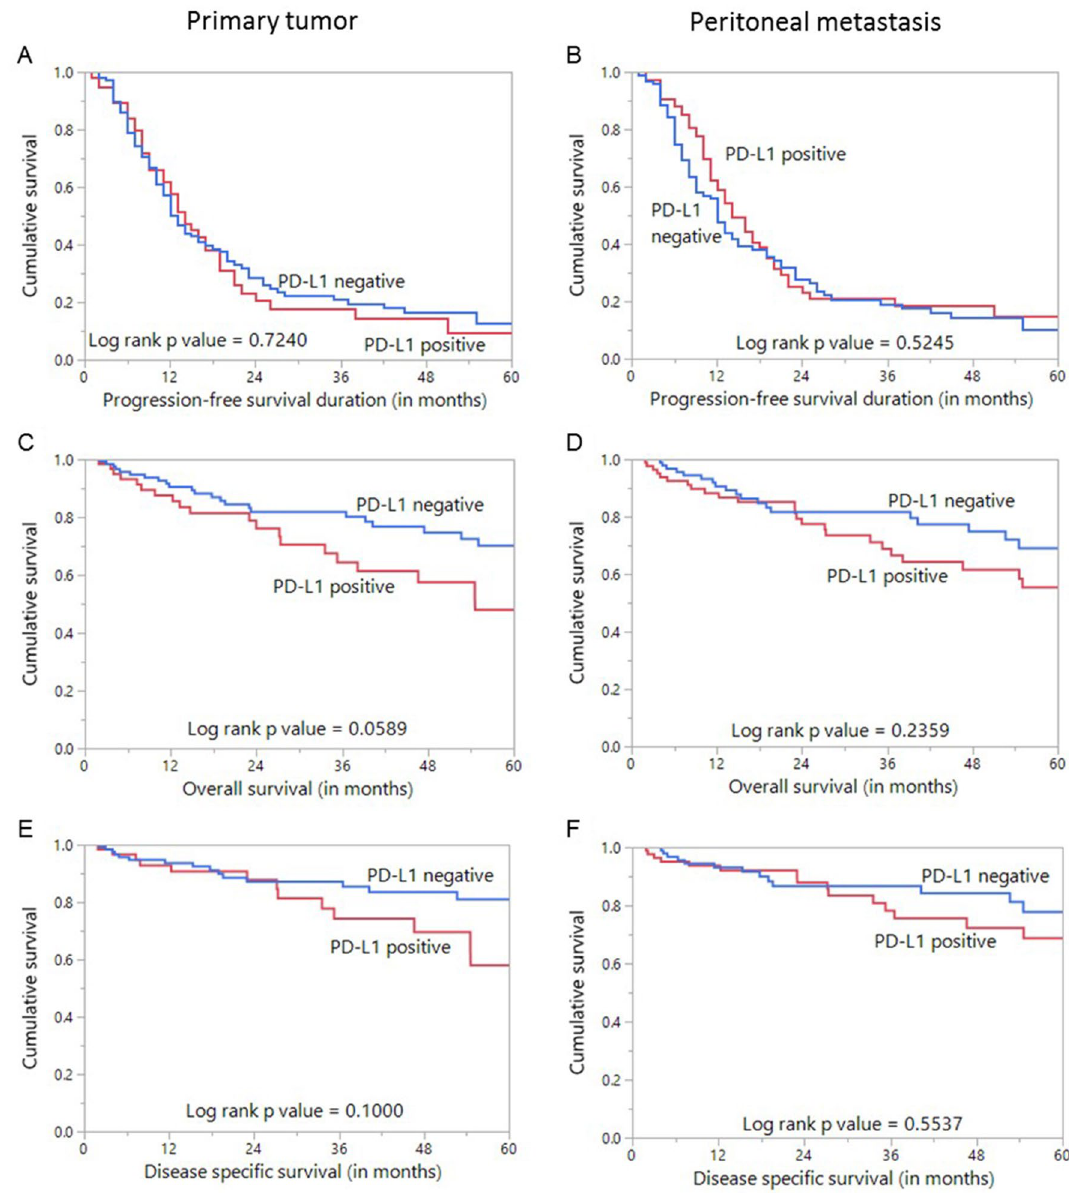
Figure 2. Survival analysis of PD-L1 protein expression in epithelial ovarian cancer. Kaplan Meier survival plot showing no statistically significant difference between PD-L1 positive and negative tumors in both primary and corresponding peritoneal metastases for progression-free survival ( A , B ), overall survival ( C , D ) as well as disease specific survival ( E , F